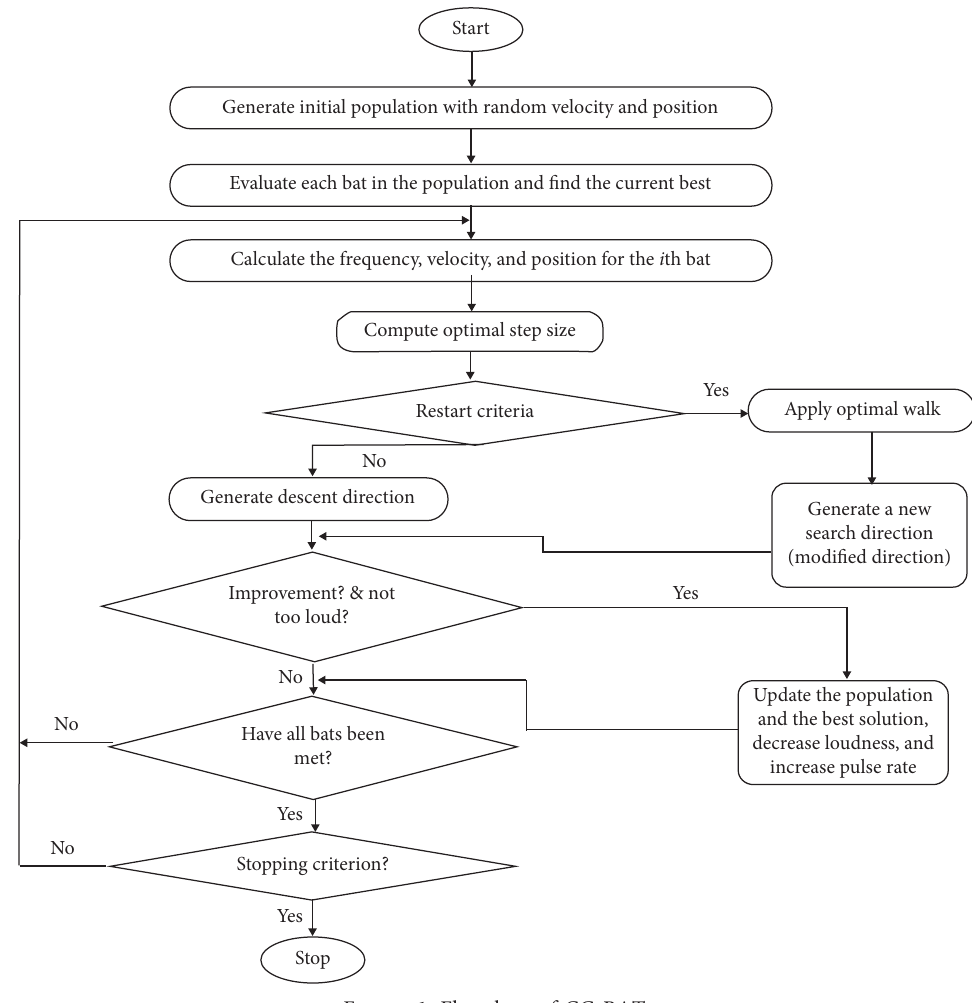
Figure 1: Flowchart of